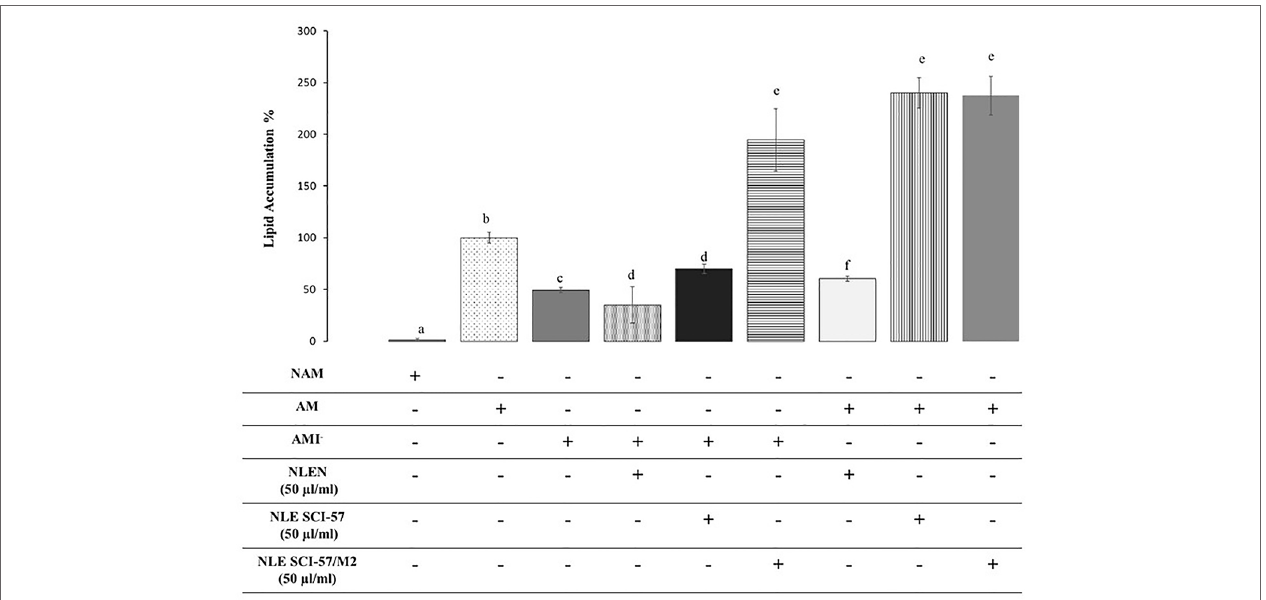
FIgUrE 10 | Effect of SCI-57 on 3T3 adipogenesis. Adipose differentiation of 3T3-L1 preadipocytes was induced in the presence (AM) or the absence (AMI − ) of 5 μg/ml insulin. Control cultures received a non-adipogenic medium (NAM). Effects of NLE preparations on 3T3-L1 adipogenesis were evaluated under both induction conditions by quantitation of intracytoplasmic lipid accumulation with oil red O. Results are presented as the mean ± S.D. of experiments in triplicate. Lowercase letters indicate significant differences according to the Mann-Whitney U test ( p ≤ 0.05).